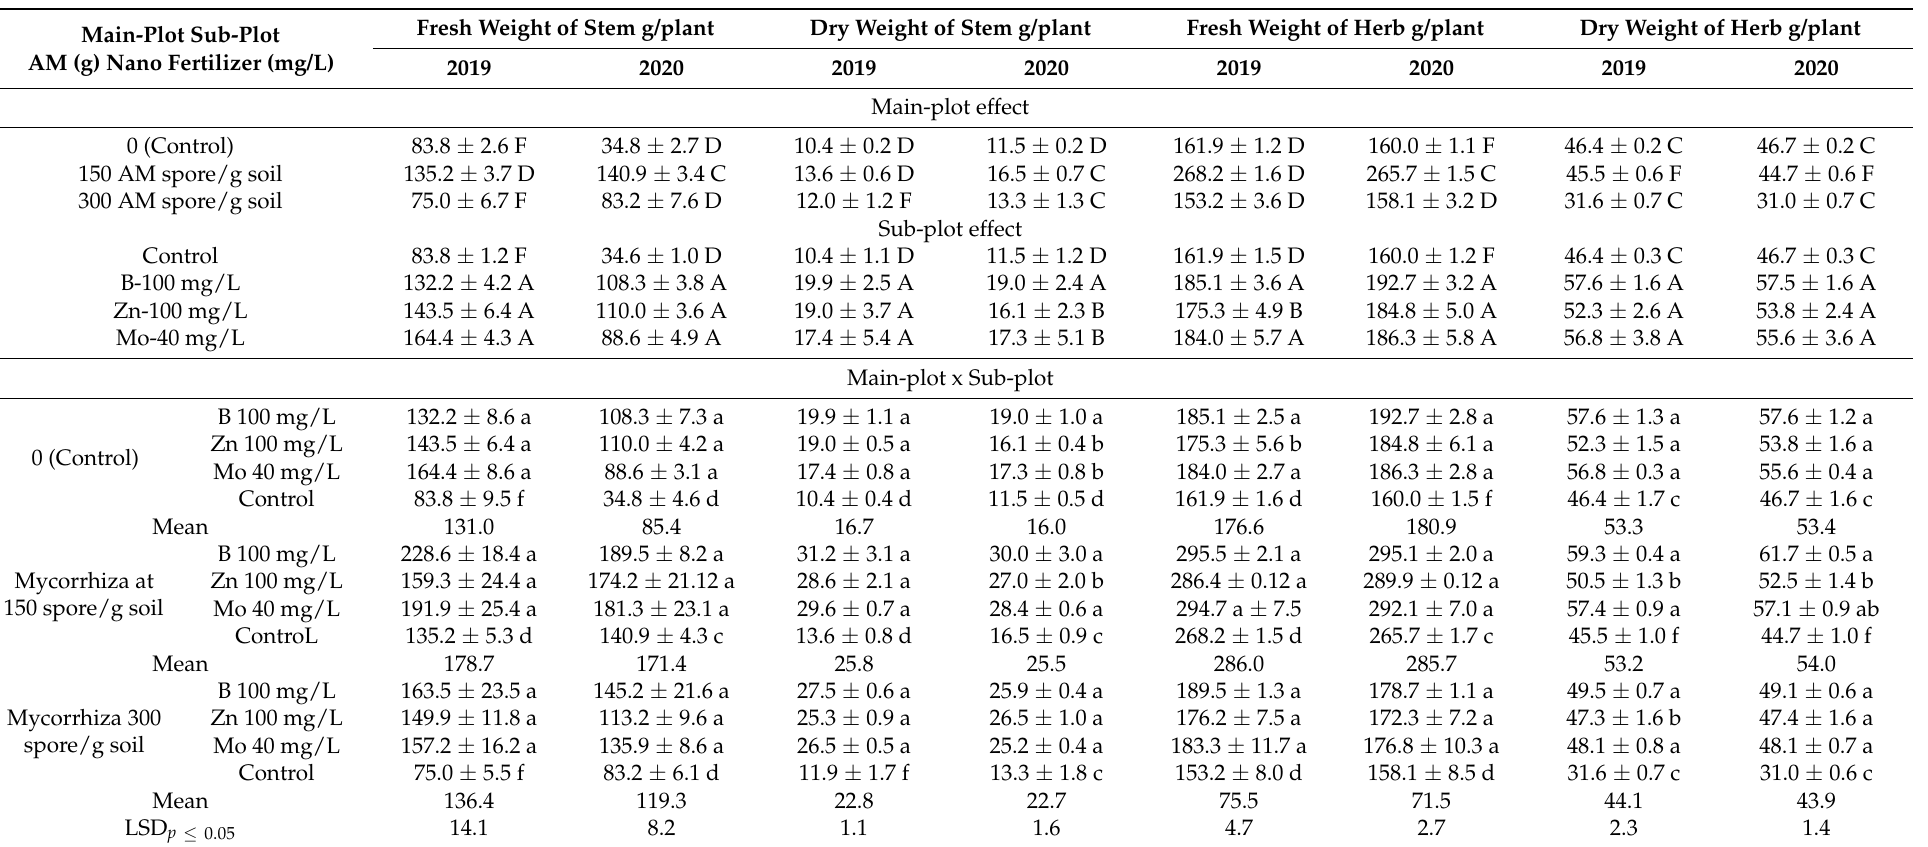
Table 2. Effect of arbuscular mycorrhiza (AM) and nano B, Zn, and Mo microelements on growth characteristics of stevia plants during 2019 and 2020 seasons. Main-Plot